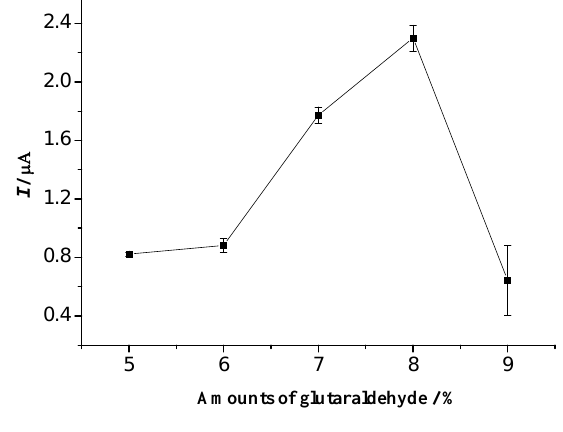
Figure 2. Effect of the glutaraldehyde concentration on the biosensor response